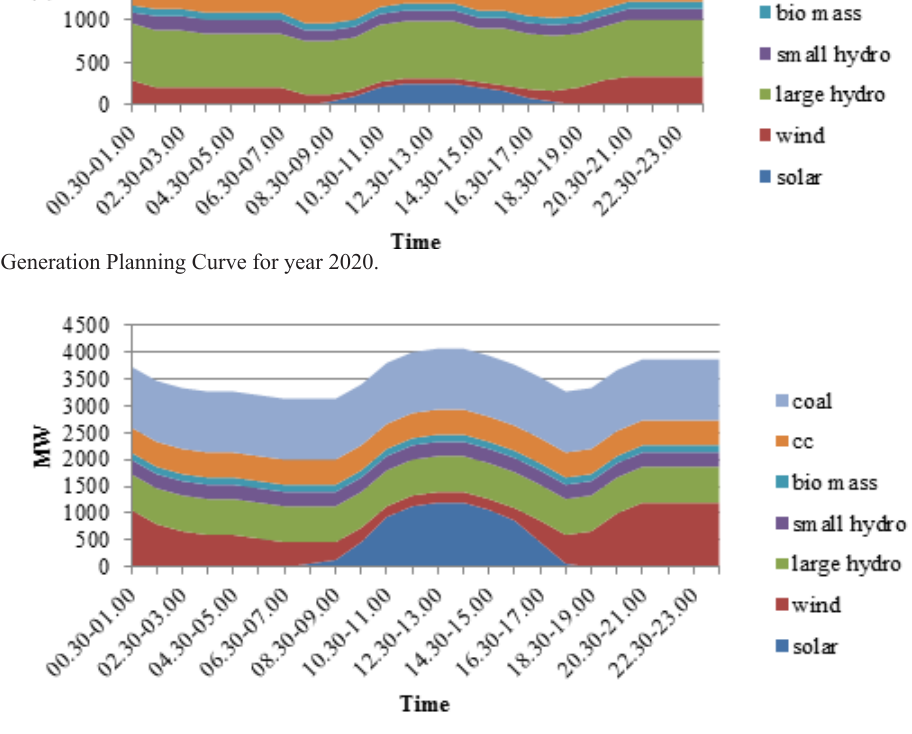
Figure 4 : Daily Generation Planning Curve for year